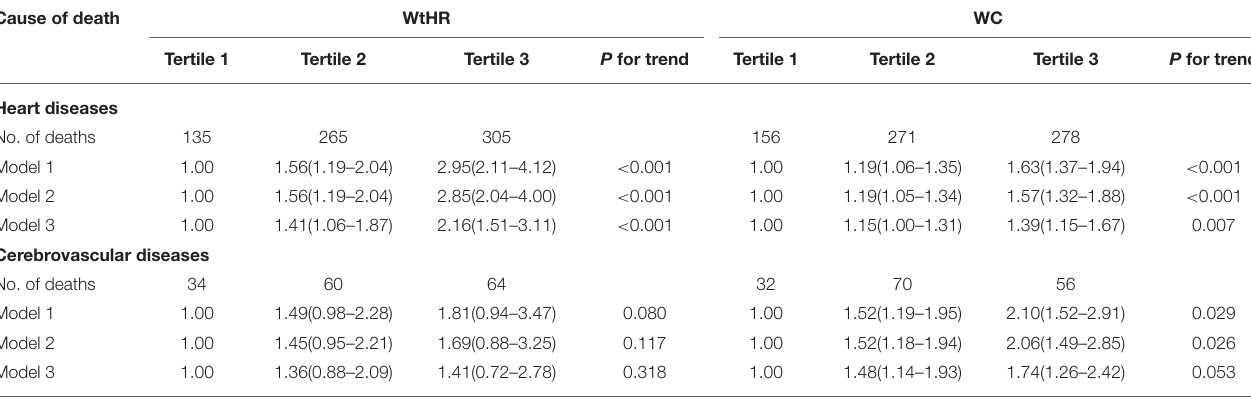
TABLE 3 | Associations between theWtHR and WC with heart and cerebrovascular diseases-specific mortality. Cause of death WtHR WC Tertile 1 Tertile 2 Tertile 3 P for trend Tertile 1 Tertile 2 Tertile 3 P for trend Heart